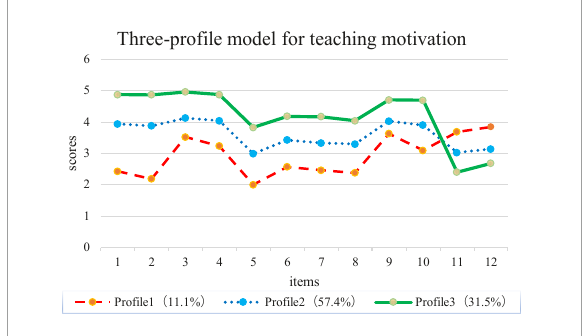
FIGURE2 Three-profile model for kindergarten teacher